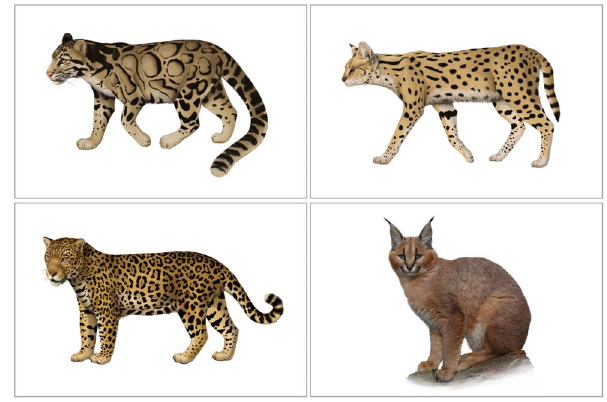
Figure 2. The pictures of the representatives of the family Felidae (the second most preferred family out of 123 examined ones). It illustrates the variation of body positions among four tested sets of pictures (for details see under Materials and Methods): clouded leopard Neofelis nebulosa (top left), serval Leptailurus serval (top right), jaguar Panthera onca (bottom left; pictures painted by Silvie Lisˇkova´) and caracal Caracal caracal (bottom right; photo from the archive of the Zoo